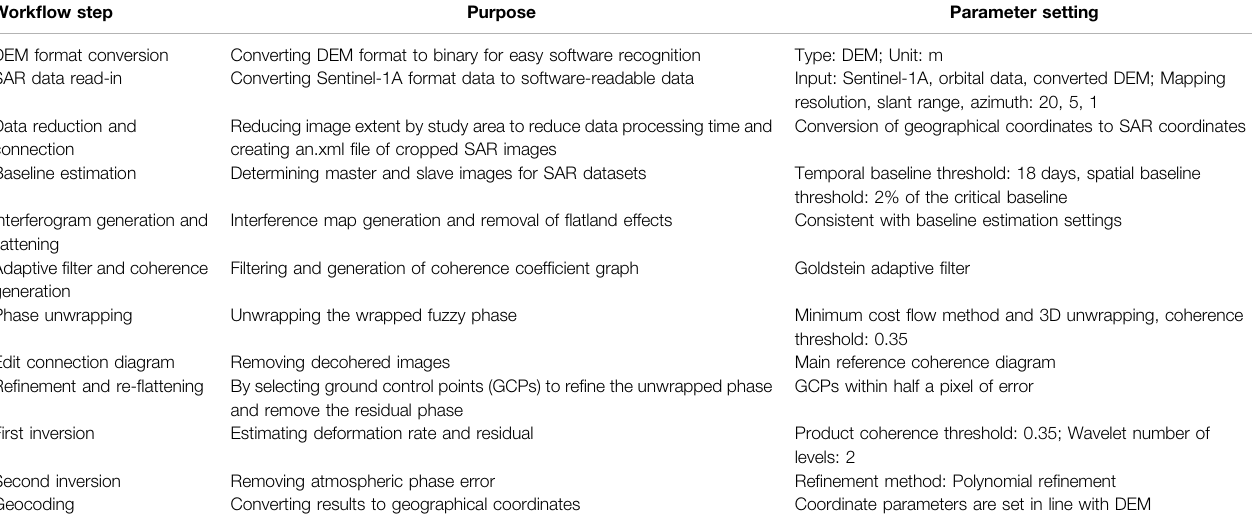
TABLE 1 | Main purposes and parameter settings of SBAS-InSAR work fl ow